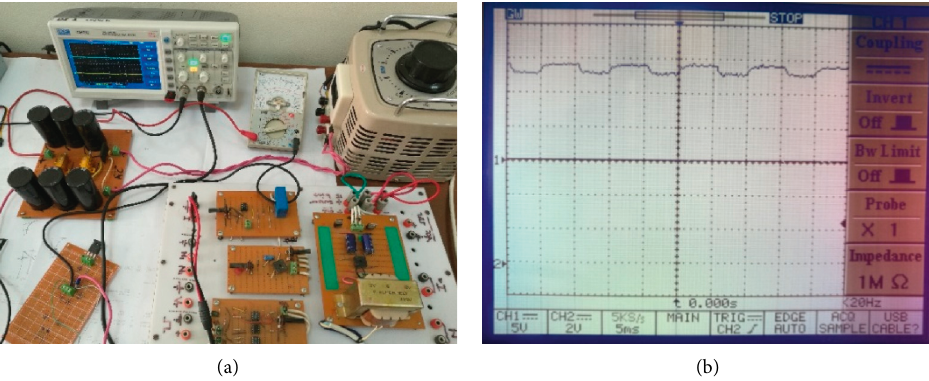
Figure 12: The experimental setup and the capacitor voltage waves.